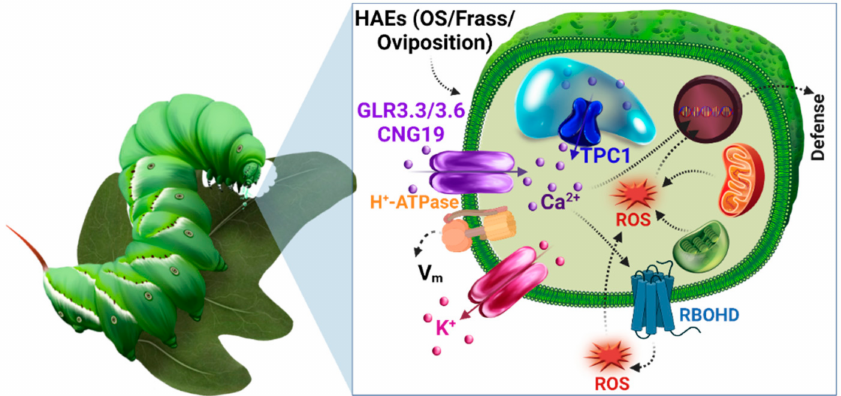
Figure 1. Initiation of early defense signaling mechanisms in response to insect herbivore attack. Schematic diagram showing herbivore M. sexta feeding induced signaling events, which include the perception of HAEs such as OS, frass, and oviposition by specialized receptors on the outer plasma membrane, which trigger modulation of V m via H + -ATPase and Ca 2+ ion influx into the cell via Ca 2+ channels, GLR3.3/3.6 and/or CNGC19. The increase in cytosolic Ca 2+ may trigger the further release of vacuolar Ca 2+ via the TPC1 channel. The subsequent release of Ca 2+ may activate nicotinamide adenine dinucleotide phosphate (NADPH oxidase) and respiratory burst oxidase homologues (RBOHDs), leading to ROS generation, and induction of plant defense responses. Illustration by Annette